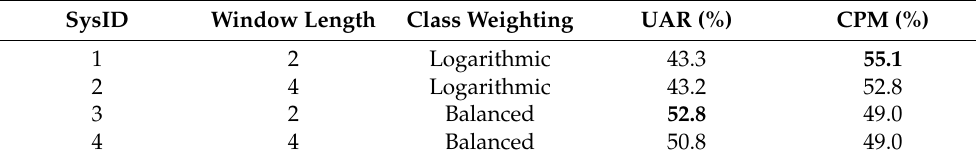
Table 4. The experimental results on a selection of temporal window length and class weighting scheme on the AffWild2 validation set. AffectNet-EE was used as an embeddings extractor; LSTM was used as a temporal aggregation technique. The best result within the column is highlighted in bold.